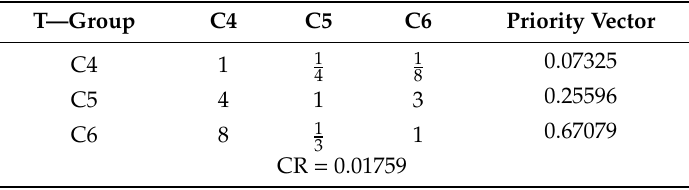
Table 5. Comparison matrix for Time criteria group.